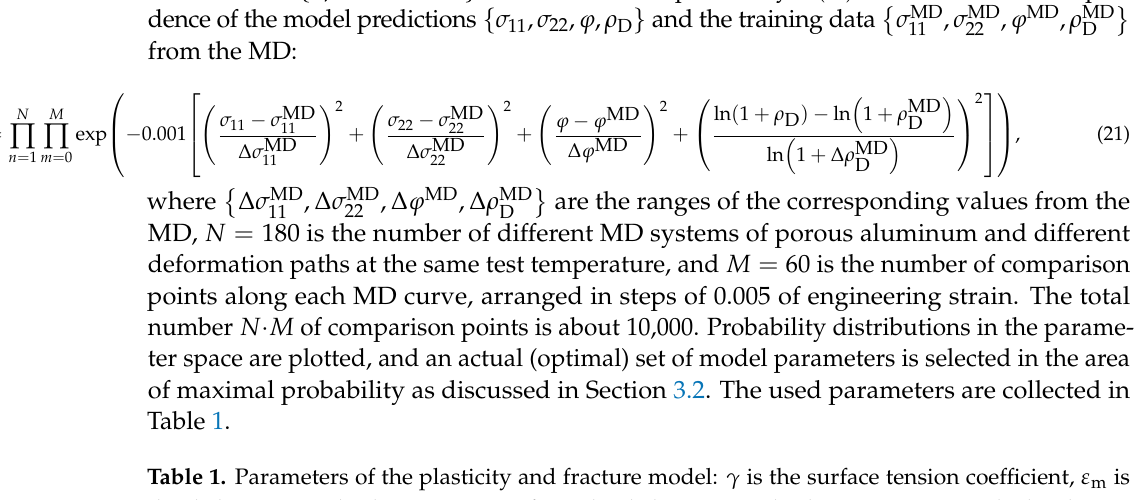
Table 1. Parameters of the plasticity and fracture model: γ is the surface tension coefficient, ε m is the dislocation multiplication energy from the dislocation multiplication term, α is the hardening coefficient from the Taylor hardening law, k n is the coefficient of the energy barrier of dislocation nucleation from the nucleation term, and k a is the coefficient of annihilation of dislocations.